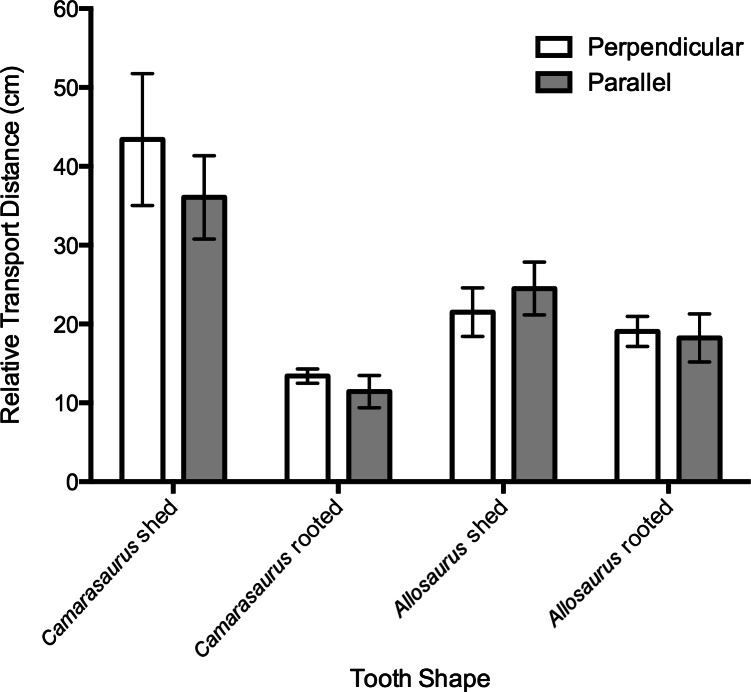
Bar chart of transport distances for tooth casts.Placed (A) perpendicular or (B) parallel to flow. Error bars represent standard error.